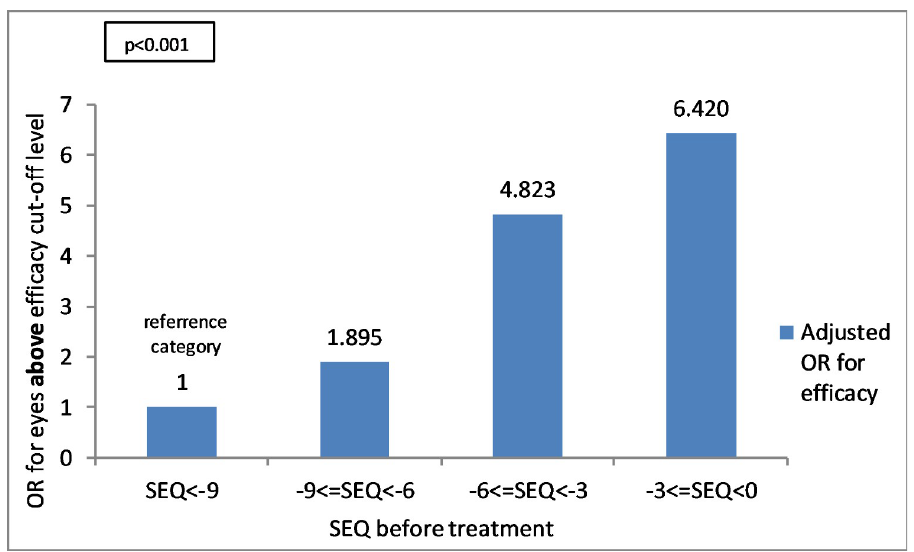
Fig 7. Relation between SEQ before treatment and OR for eyes above efficacy index cut-off level using multivariate analysis and logistic regression model (p < 0.001). OR value is regarding the reference category. SEQ = spherical